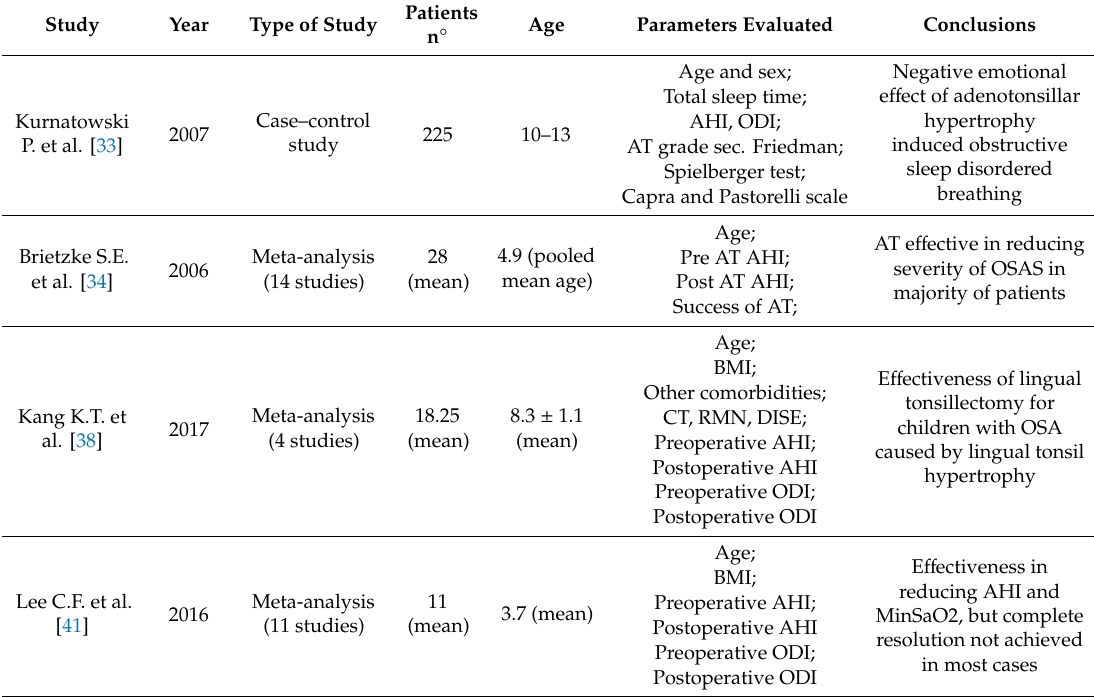
Table 3. Studies that have analyzed adenoid and / or tonsil hypertrophy as a pediatric OSAS risk factor.